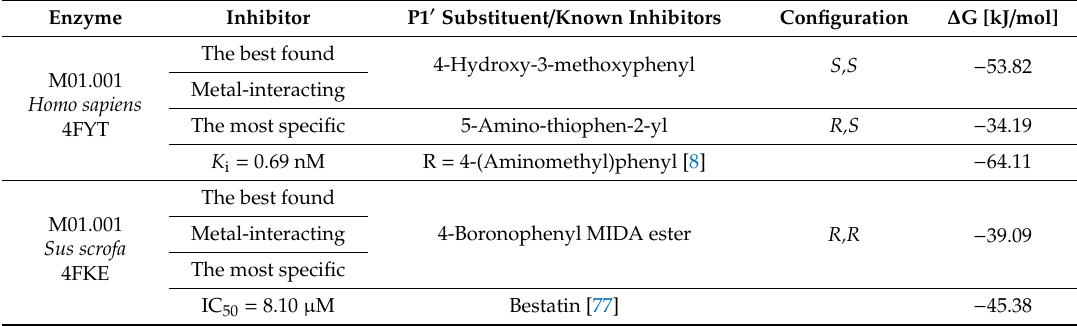
Table 3. Selected members of the M1 family with preferred P1 (cid:48) substituents (R, compare Figure 1) that were the most favored, had the best interaction with the catalytic metal ion via the phosphinate group, and were the most specific (compare explanation in the text) are shown. The stereochemistry of the ligands and the calculated Gibbs free energy of binding to the active center are included. Known inhibitors are given as the references, with inhibition potency ( K i or IC 50 ) and calculated ∆ G